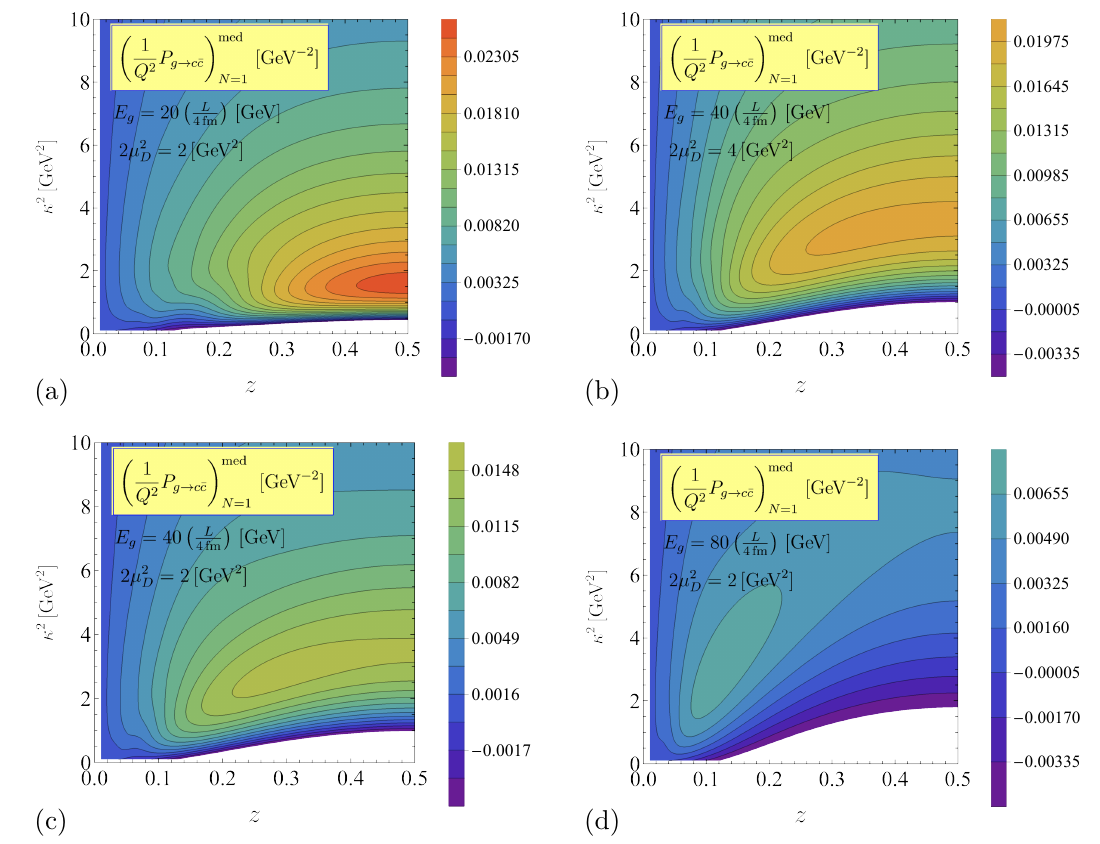
Figure 4 . The medium modification of the g → c ¯ c splitting evaluated in the N = 1 opacity approximation for ‘hard’ Yukawa-type scattering centres (3.20). (a) is the same as figure 3(b). Different panels show results for different values of the typical squared momentum 2 µ 2 from the scattering centre and for different gluon energies E